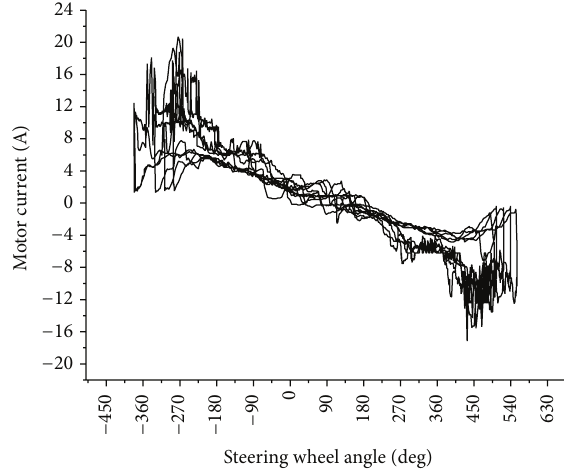
Figure 8: Linear assistant characteristics in the test.